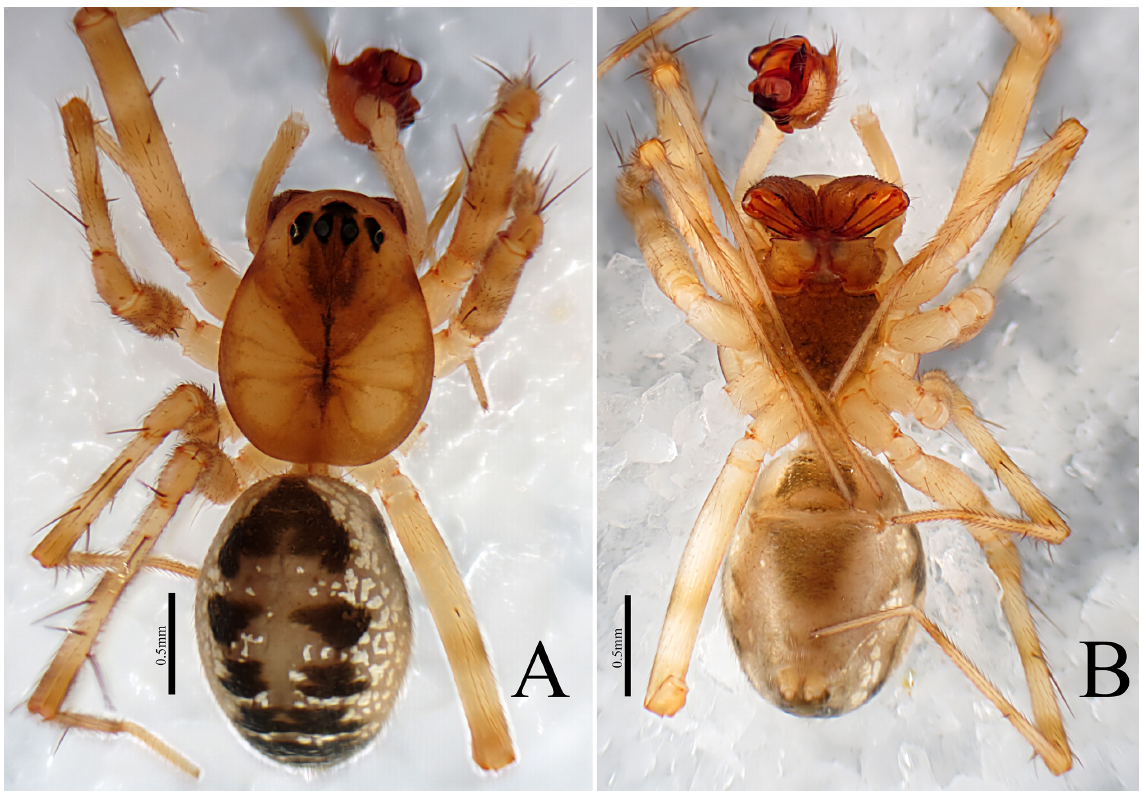
Fig. 4. Acroterius absentus gen. et sp. nov., ♂, holotype (HNU-Tang031027). A . Habitus, dorsal view. B . Habitus, ventral